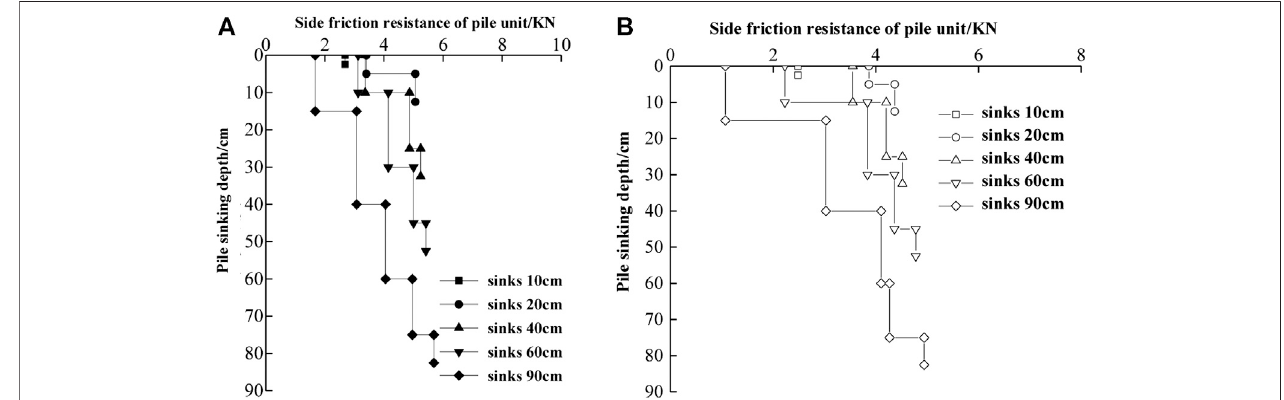
FIGURE 14 | Load curve of the entire pile of test piles. (A) Test pile TP1 (B) Test pile TP2.